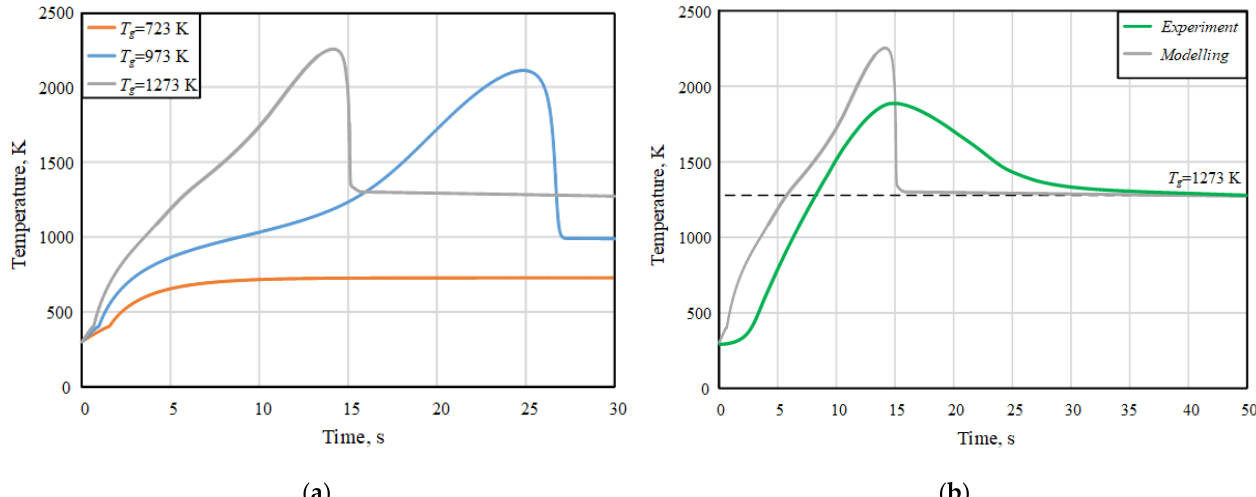
Figure 9. Time dependences of maximum temperature of CLF droplets No. 5 (FC 90% + cardboard 10%) under radiant heating ( V g ≈ 0): ( a ) simulation results at different heating temperatures; ( b ) simulation results vs. experimental data [41] at T g = 1273 K.